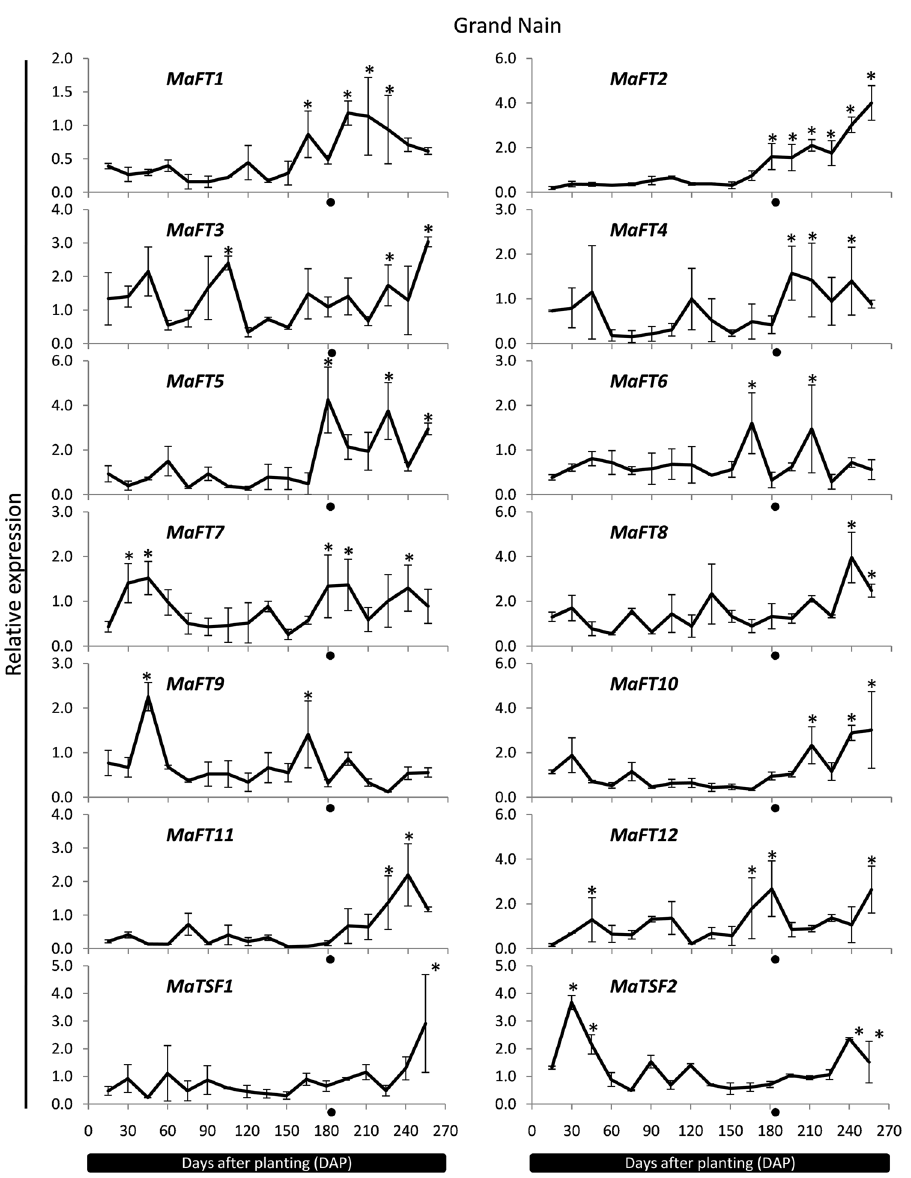
Figure 5. Time-course expression patterns of banana FT / TSF genes during development in Grand Nain by qRT-PCR. The RPS2 gene of each is used as reference gene. The transition from vegetative to reproductive stage is shown by an asterisk. The values are means of two biological (each containing a pool of leaves of five plants) and three technical replicates ( ± SE). Analysis was performed using the Tukey-Kramer multiple comparison test by GraphPad software. The asterisks ( * ) indicate significant differences (P <